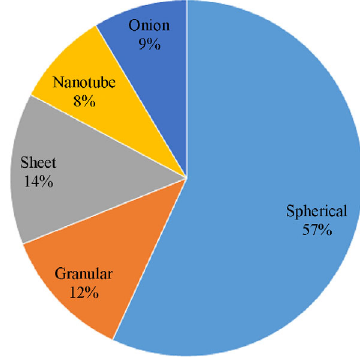
Fig. 2 Statistics of NP morphology